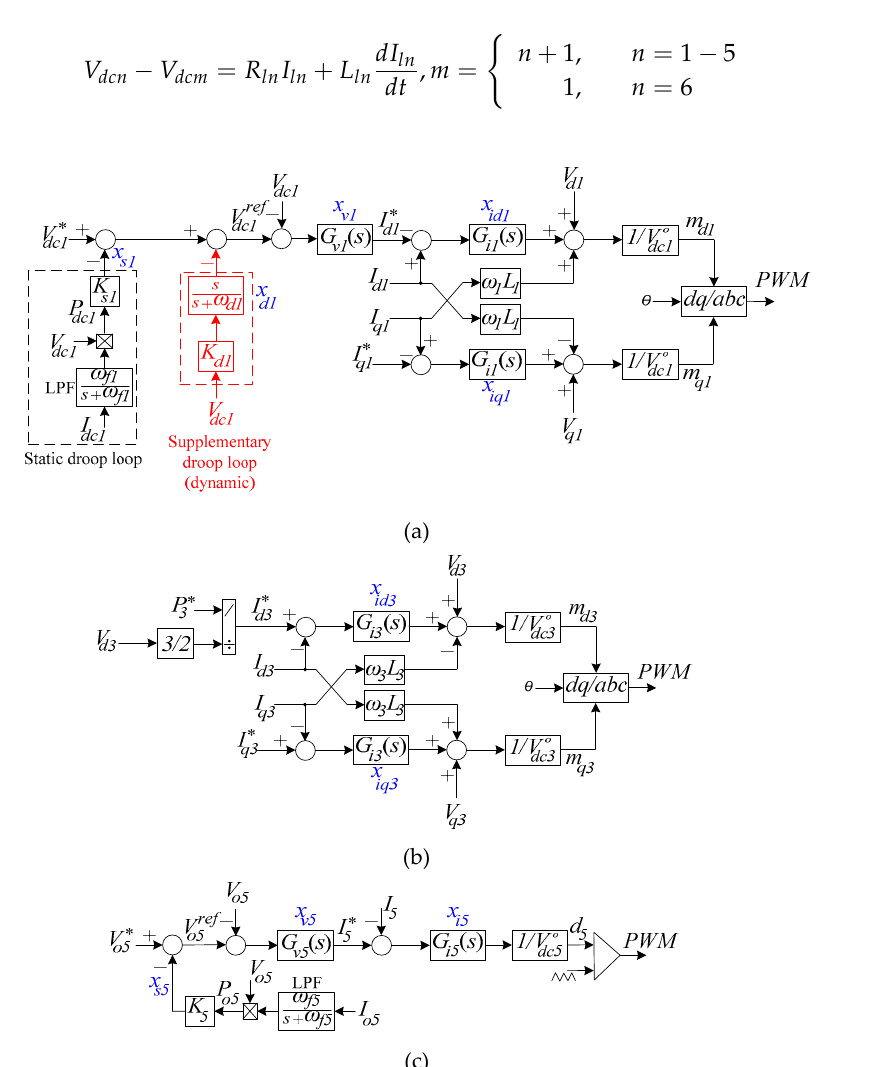
Figure 2. The control structure of the MTDC entities. ( a ) VSRs (VSC1-2); ( b ) VSIs (VSC3-4); ( c ) DC/DC converters (5-6).